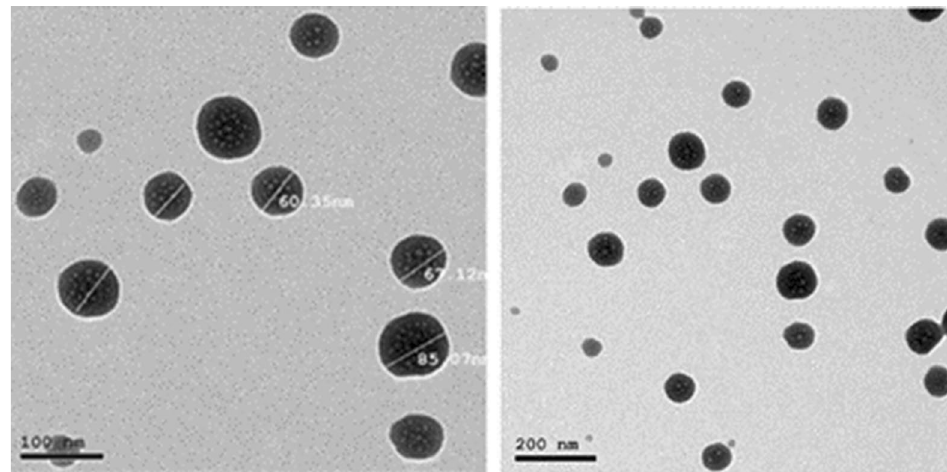
Fig. 3 TEM of nano calcium hydroxide particles indicating spherical and cubic shape with 15.57